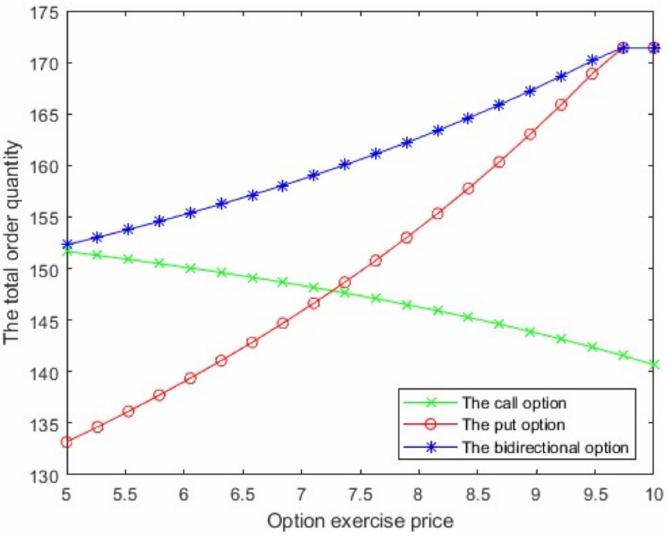
Figure 4. The total order